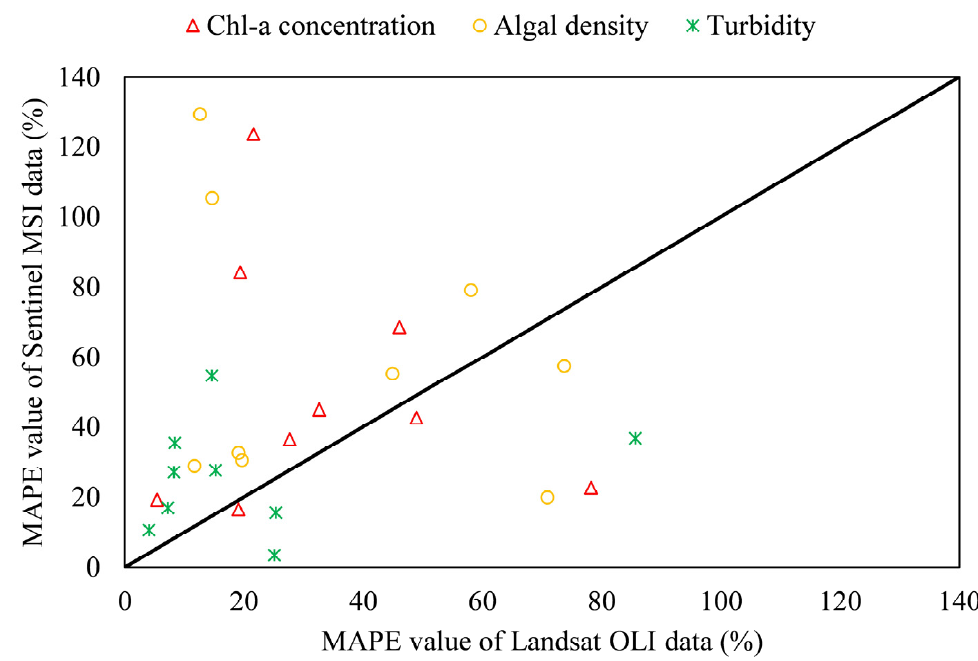
Figure 4. MAPE value of Landsat OLI and Sentinel MSI data with the same or similar time points. In conclusion, the Landsat OLI data are determined to be the retrieval data for this study. Figures 5–7 show the best regression models for estimating chlorophyll a concentra- tion, algal density, and turbidity from Landsat OLI data.